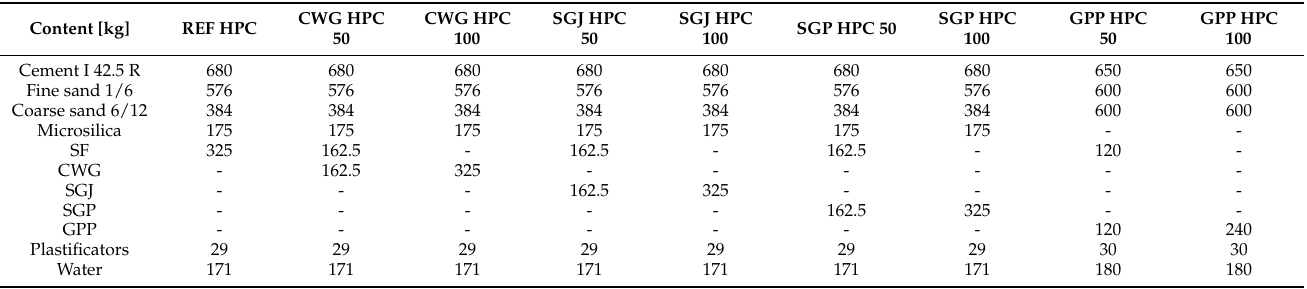
Table 1. Composition of concrete